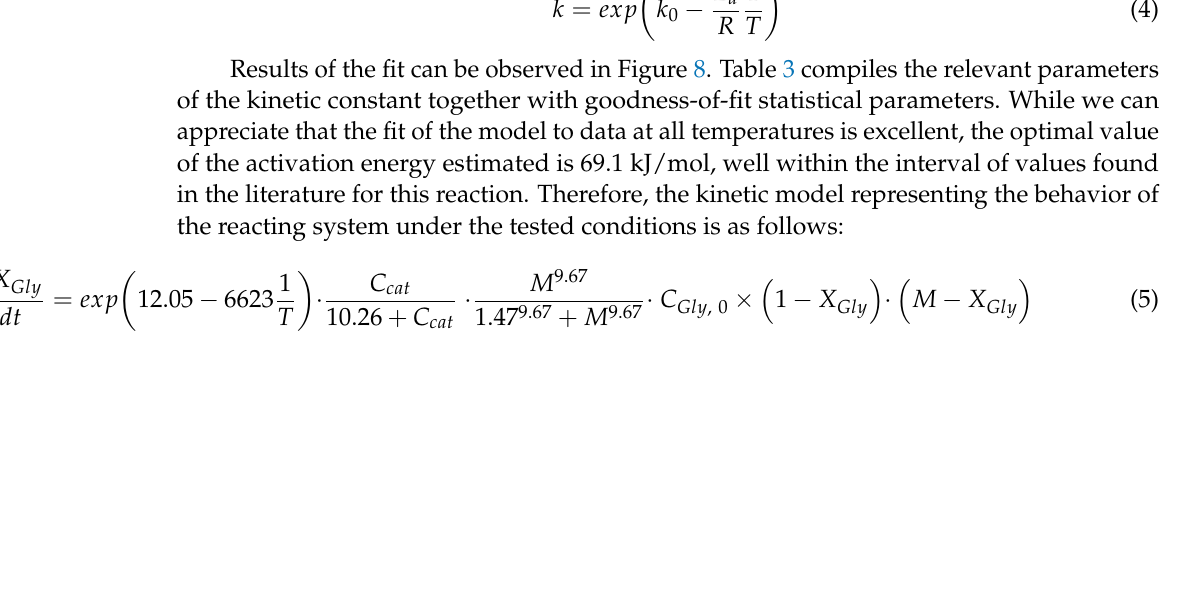
9 of 14 Table 1. Values and standard errors of the kinetic constants calculated by fitting the kinetic models to experimental results retrieved at 80 °C and diverse catalyst concentrations as well as reagent molar ratios. Model 1.47 ± 0.012 Table 2. Statistical parameters calculated by fitting the kinetic models to experimental results: